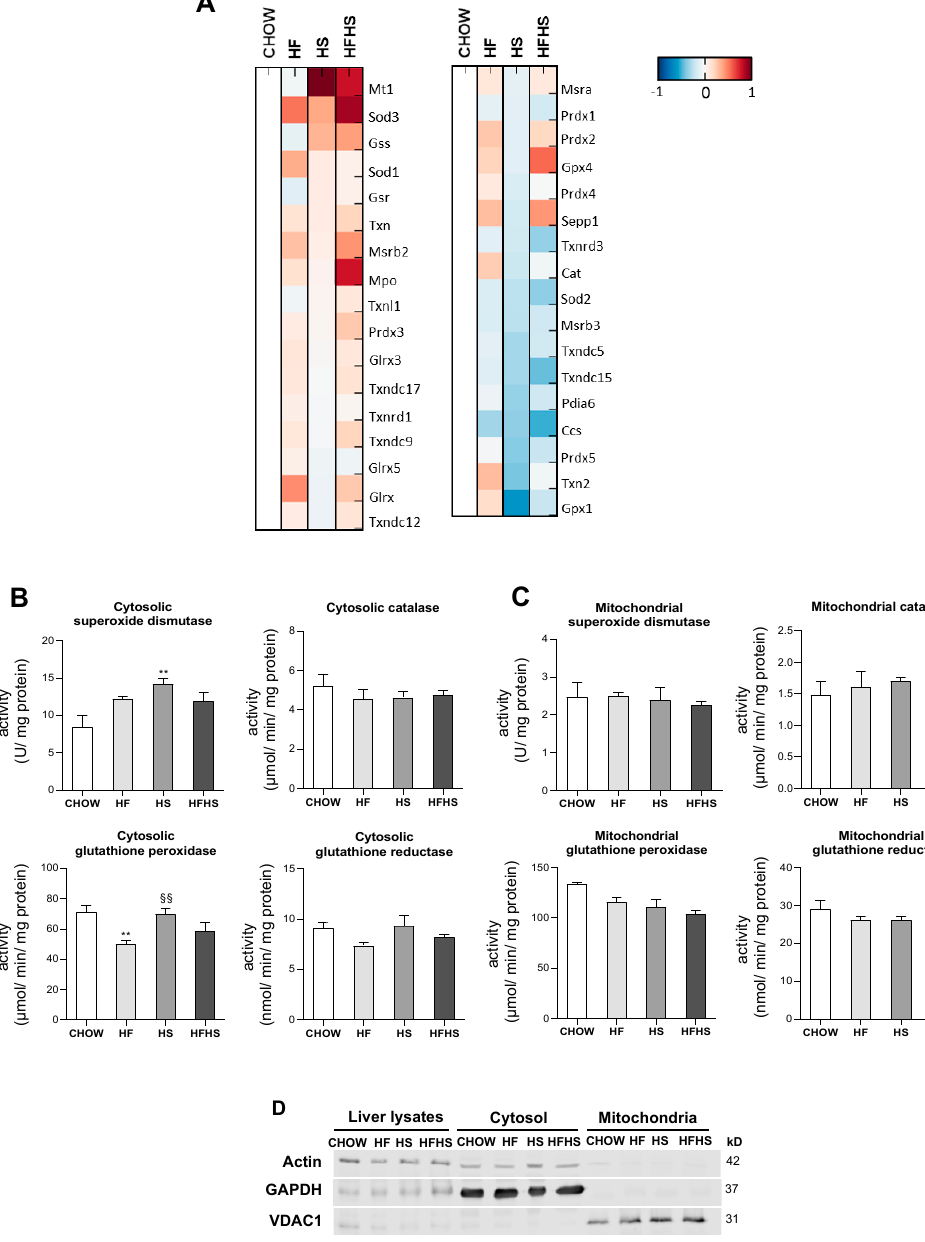
Figure 7. HF, HS and HFHS diets lead to an imbalance in antioxidant enzyme activities in the cytosolic fraction but not in the mitochondrial fraction. ( A ) Proteomic analysis of antioxidant enzyme levels in hepatic tissue ( N = 4). Blue represents decreased levels, and red represents increased levels. ( B ) Antioxidant enzyme activities of superoxide dismutase (SOD), catalase, glutathione peroxidase